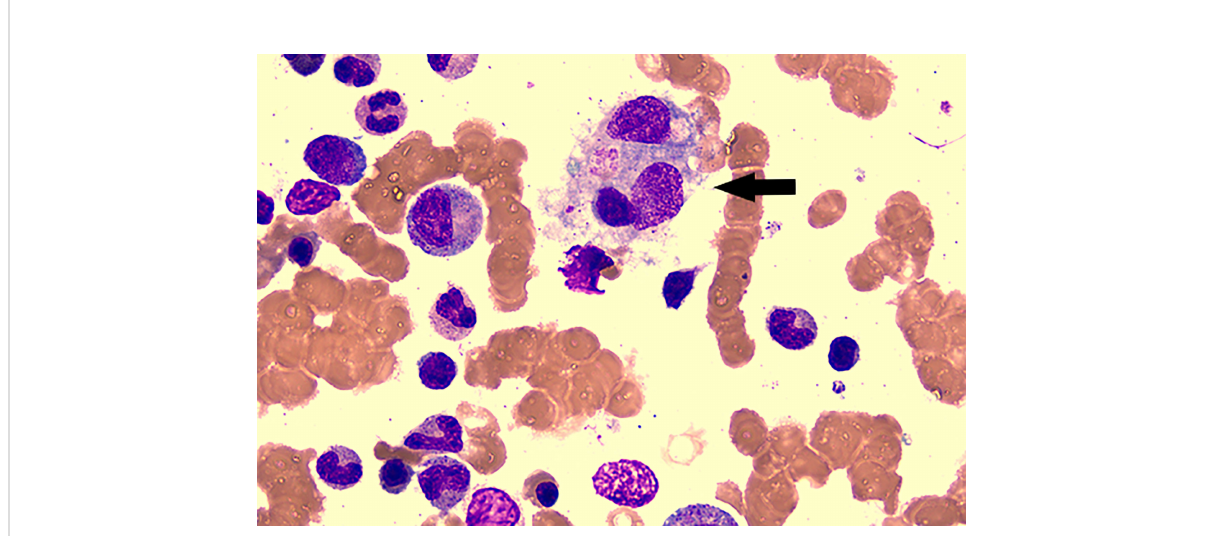
FIGURE 2 Bone marrow aspirate smear showed the evidence of hemophagocytosis; original magni fi cation